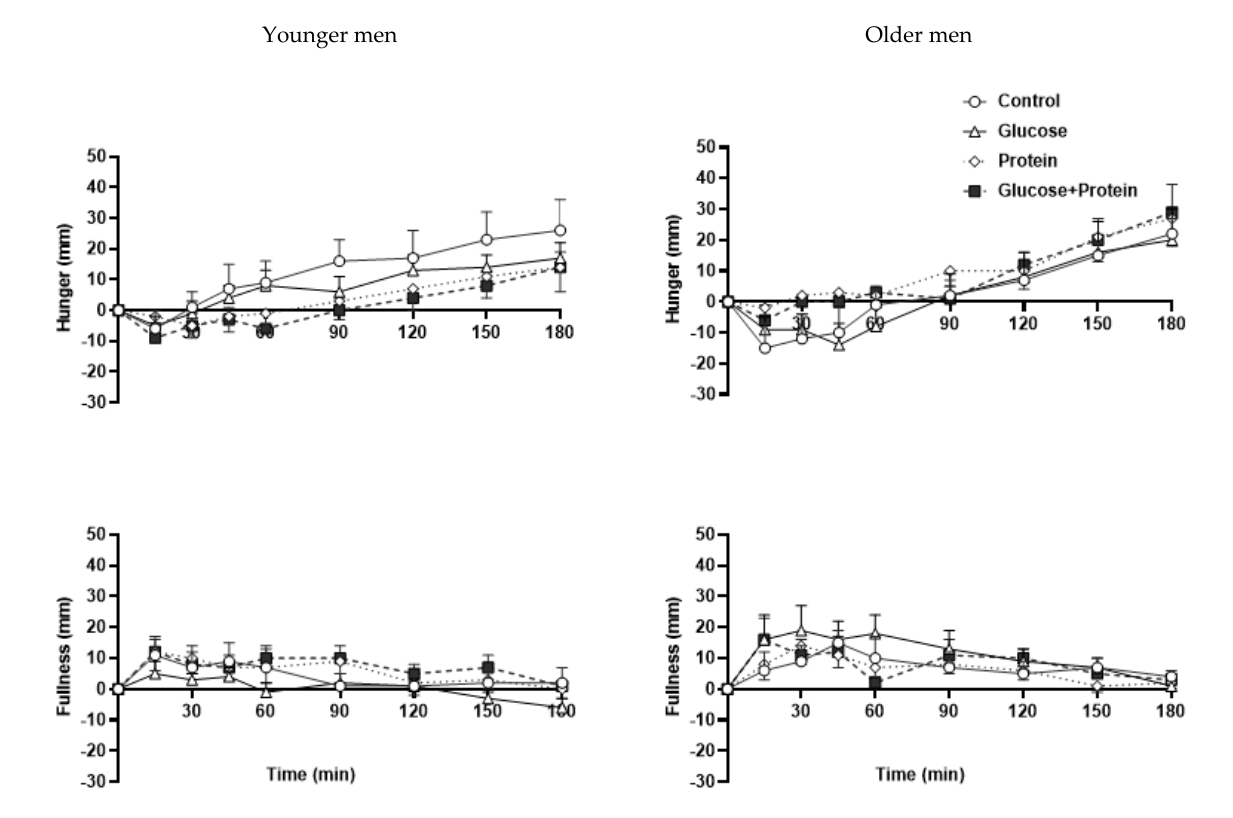
Figure 3. Mean ± SEM visual analogue score (VAS) of hunger (mm) and fullness (mm) following drink ingestion containing (i) flavored water (C, control, ~2 kcal), (ii) 30 g whey protein (P), (iii) 30 g glucose (G) or (iv) 30 g whey protein + 30 g glucose (GP) in younger and older men. Effects of age and drink condition and the interaction effect were determined using a mixed-effect model with baseline concentrations as covariates and post hoc Bonferroni correction. T = 0 min refers to the point immediately before the drink consumption. Age by drink-condition interaction effects : p = 0.02 hunger was suppressed by P and GP in younger but not older men; p = 0.01 fullness was less following G compared with the other drinks in younger but not older men.